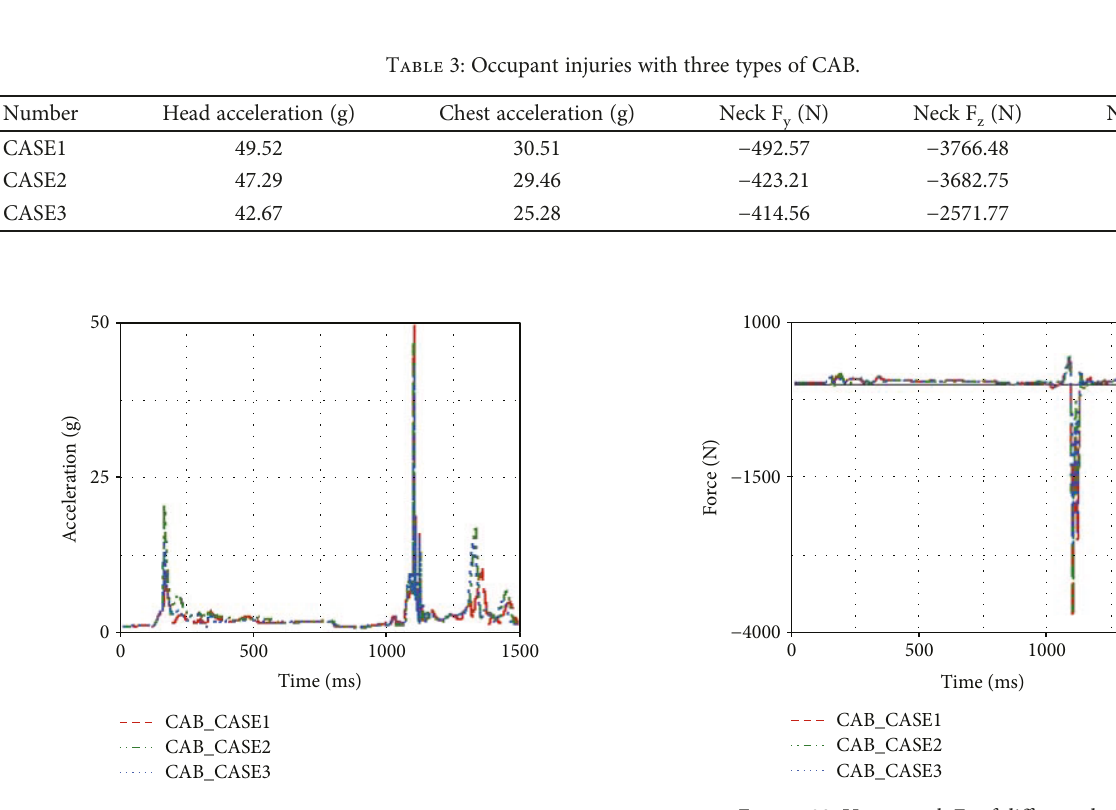
of di ff erent z